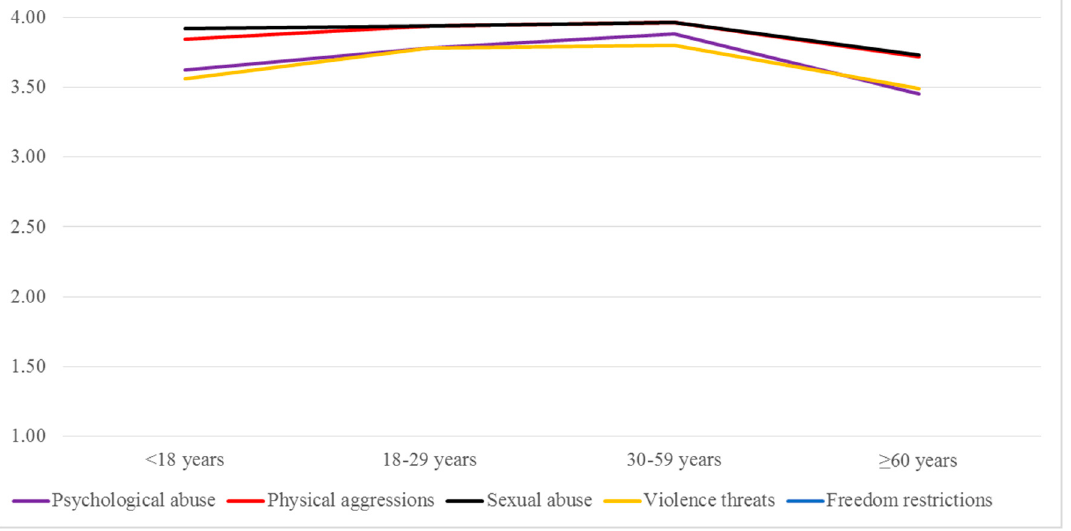
Figure 5. Perceived severity of IPVAW types: means by age groups.